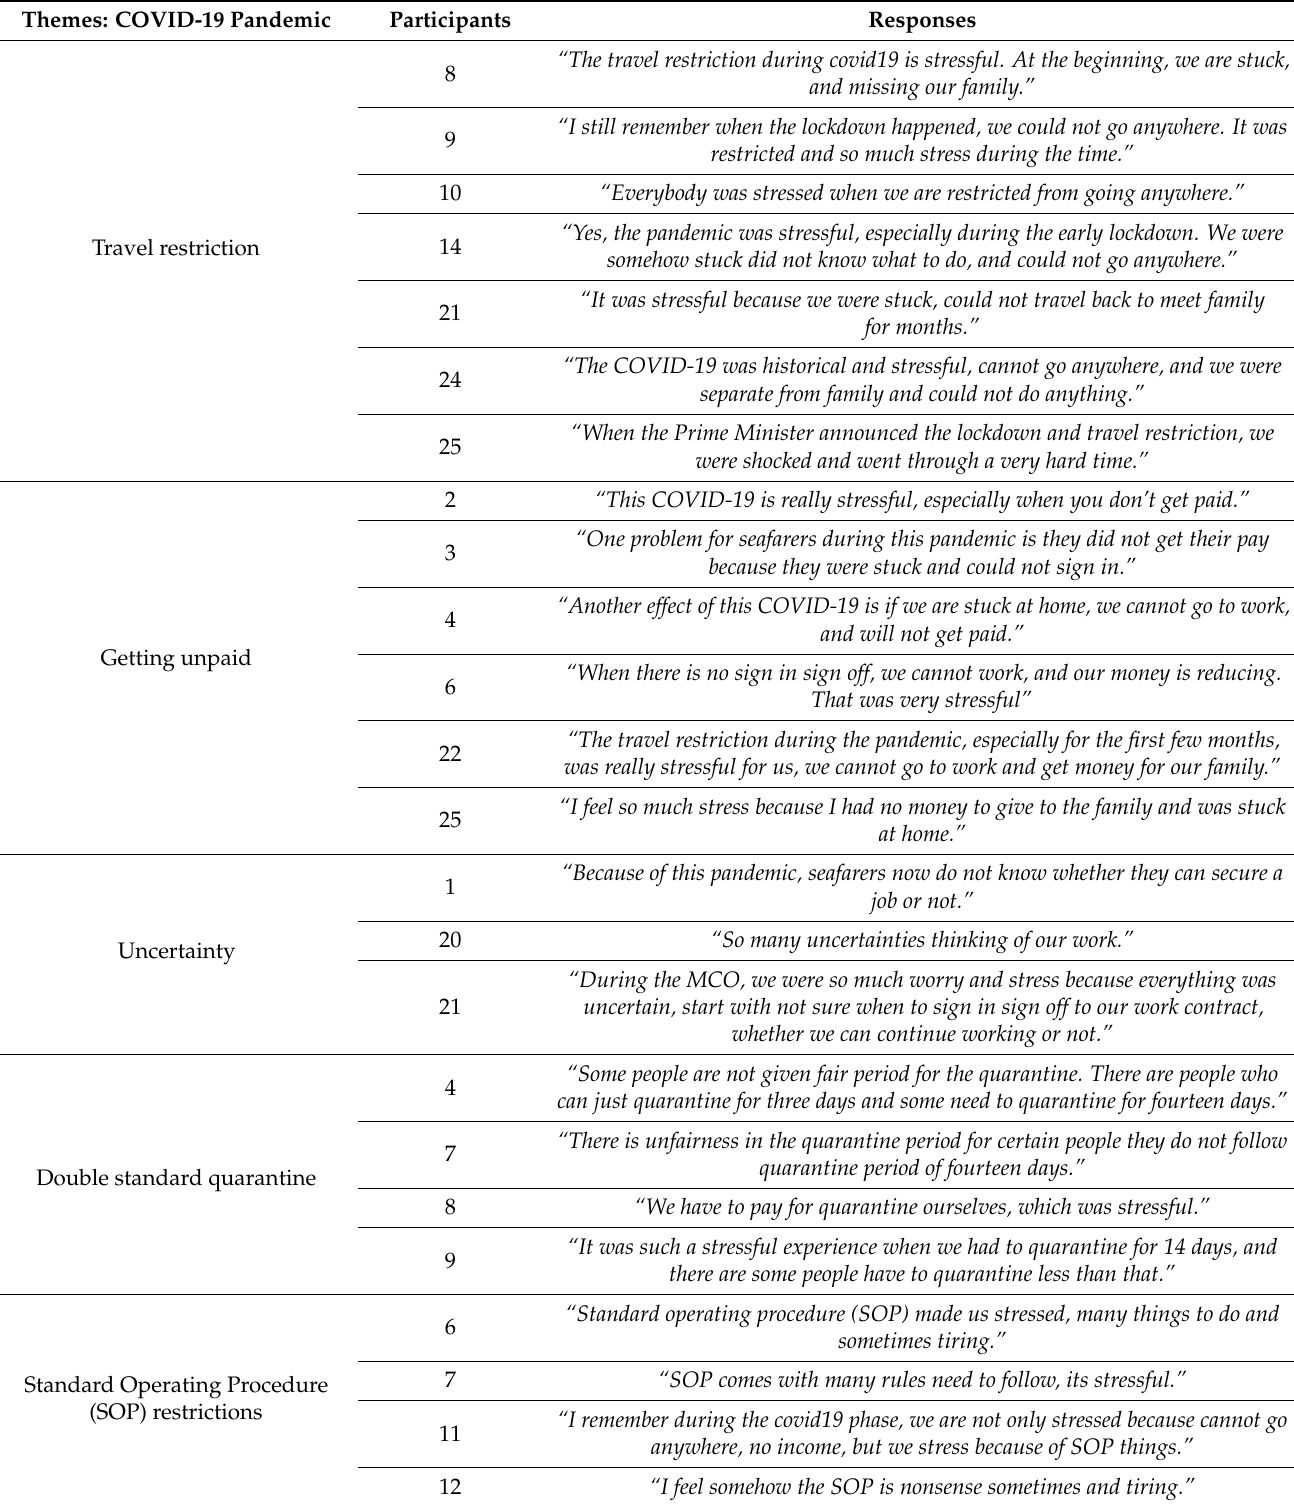
Table 9. Theme of COVID-19